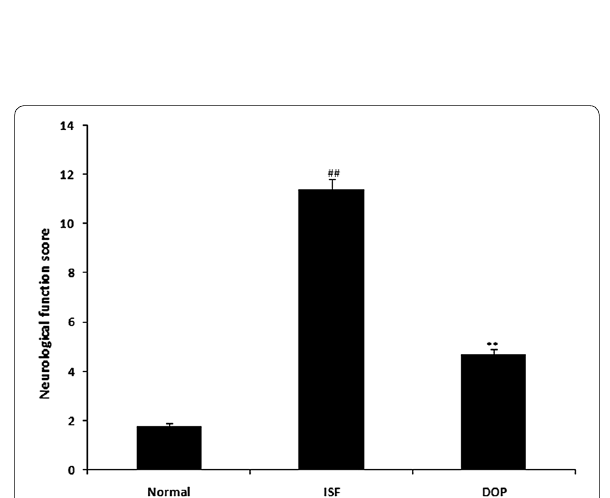
Fig. 2 Desoxyrhapontigenin ameliorates the neurological score in rats with anaesthesia-induced neuronal injury. Mean ## p < 0.01 vs. controls; ** p < 0.01 vs. ISF